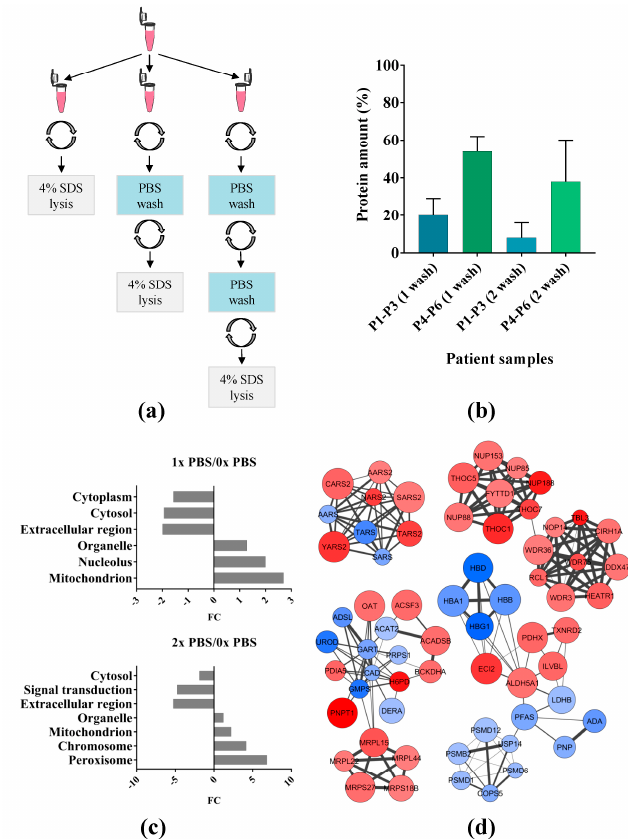
Figure 1. The effect of phosphate buffered saline (PBS) wash(es) on the acute myeloid leukemia (AML) proteome. ( a ) Experimental design including one and two PBS washes of the primary AML cell pellets; ( b ) Protein amounts observed in six patient samples after one and two PBS washes represented with the mean and standard deviation (SD). P1–P3 are patient samples containing approximately 8 million of primary cells each while P4–P6 patient samples contain higher amounts of primary cells (ranging from 8 to 30 million); ( c ) Enrichment analysis of gene ontology (GO) terms by a GO tool software using the GO slim search mode; ( d ) Major protein clusters identified with MCode. Protein nodes are colored with red when they are more abundant in samples washed with PBS once and with blue when they are more abundant in unwashed samples. Increased size of nodes reflects a more significant p -value and thicker edge width represents a more confident interaction from STRING